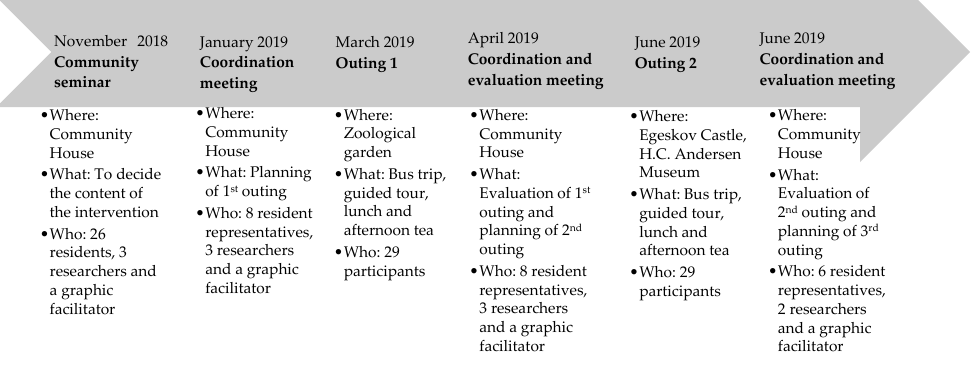
Figure 1. Co-creation process and intervention components.